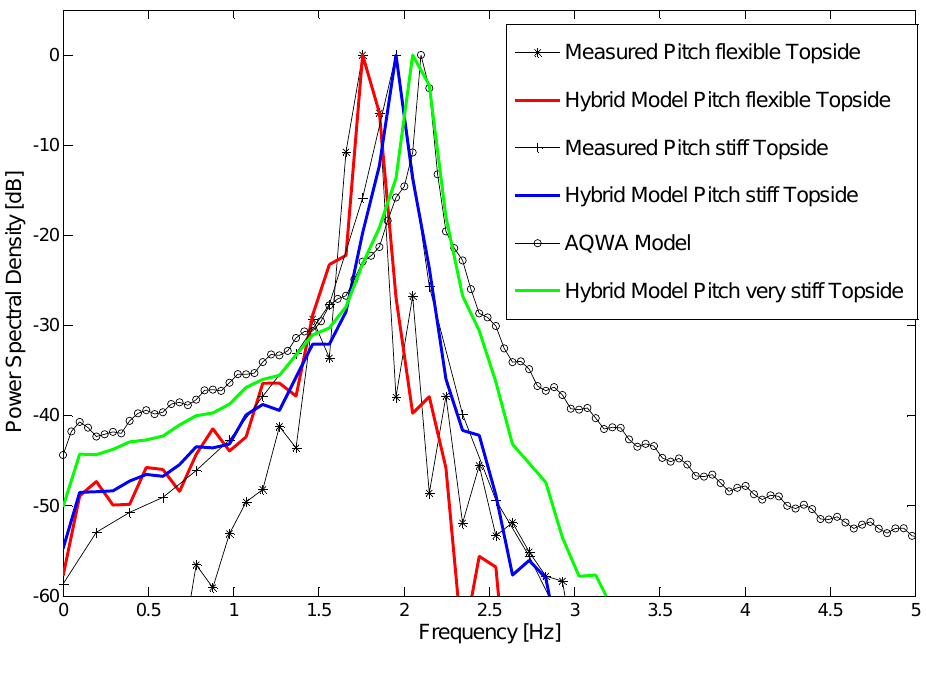
Figure 13. Code-to-code and code-to-experiment power spectral density comparison of the pitch motion decay response for the quasi-rigid, stiff and flexible hybrid